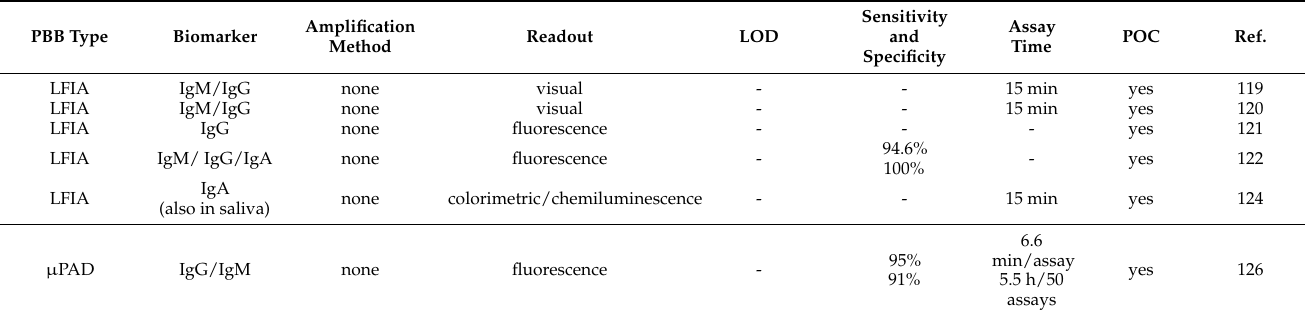
Table 3. SARS-CoV-2 antibody detection